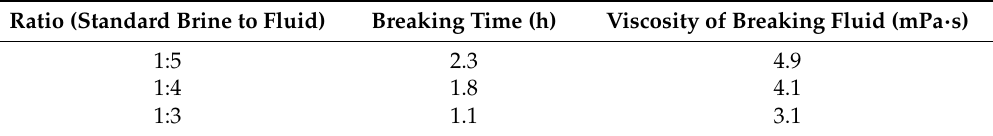
Table 1. 3 wt % viscoelastic surfactant (VES) fluid gel breaking at different brine ratios. Ratio (Standard Brine to Fluid) Breaking Time (h)